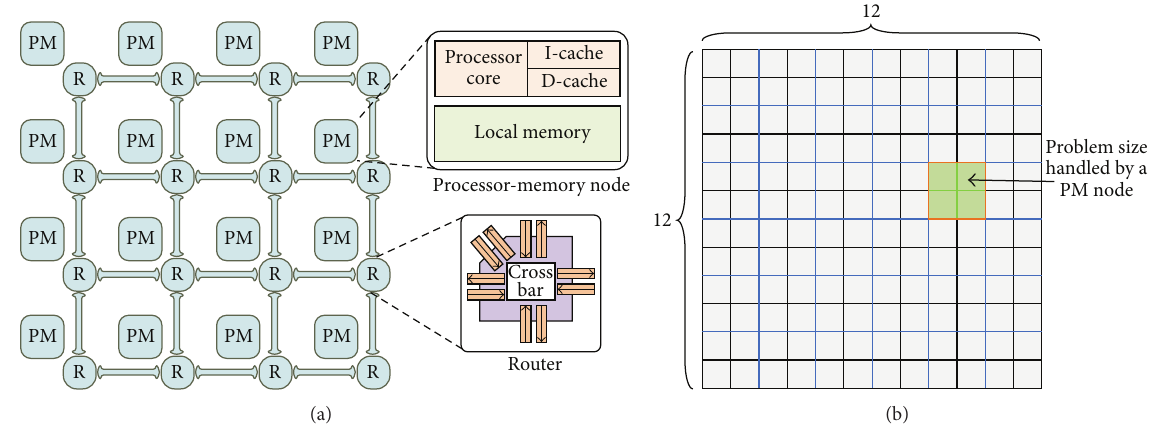
Figure 1: (a) Sketch map of homogenous OLPCs and (b) an example of data partitioning of data-parallel applications.